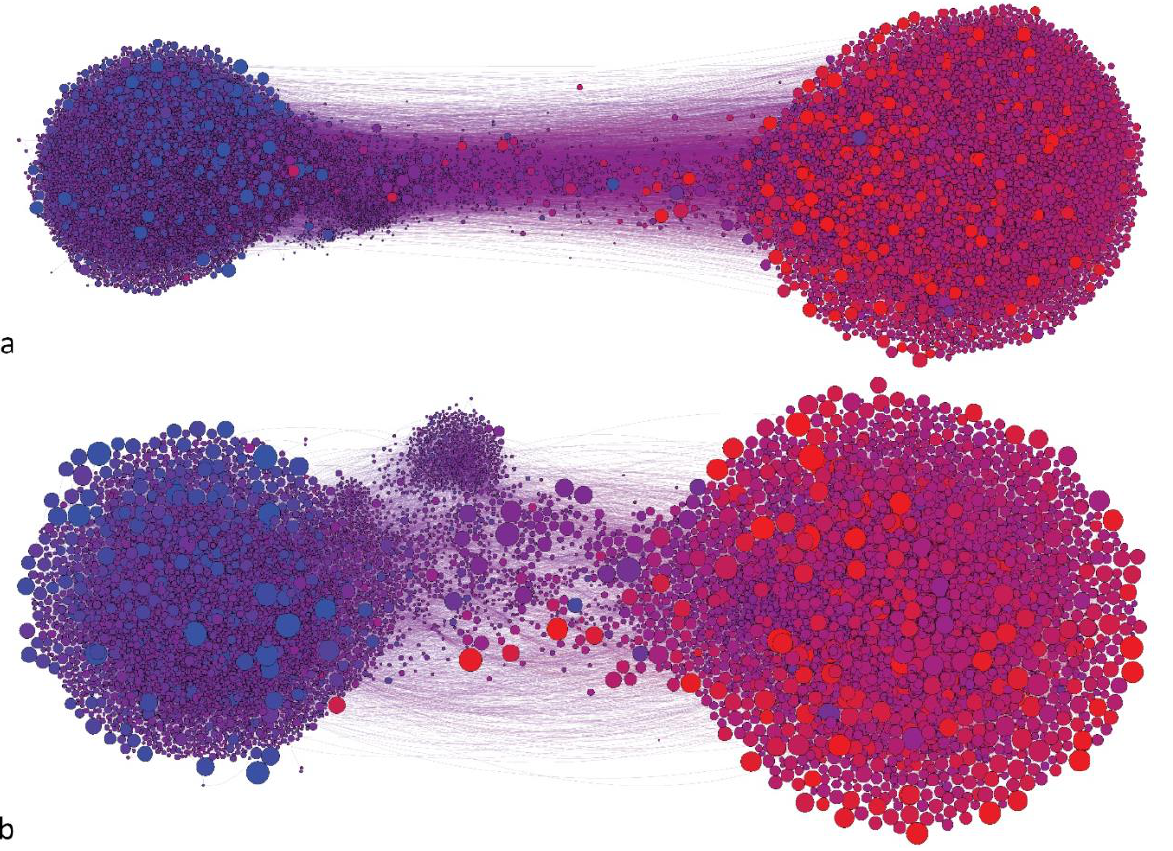
Figure 1. Echo-chamber structure of (a) friend/follower network and (b) diffusion network. Node color and size are based on partisanship and misinformation, respectively. See Methods for further